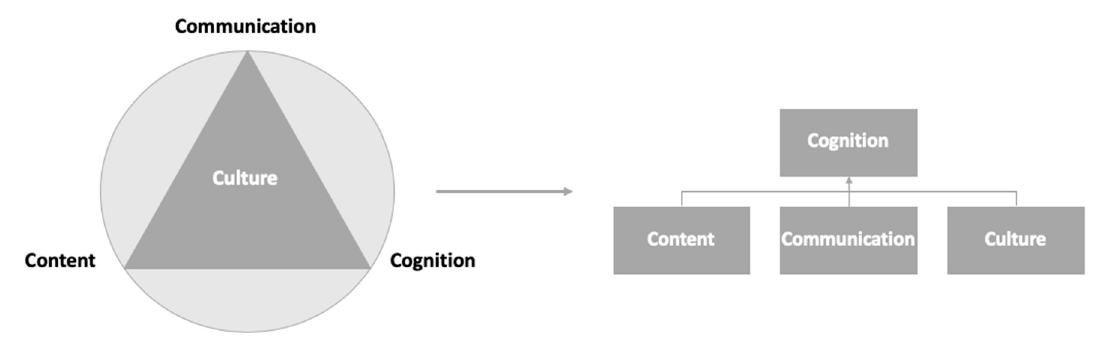
Figure 2. Rearrangement of the 4 Cs: cognition, content, communication and culture.